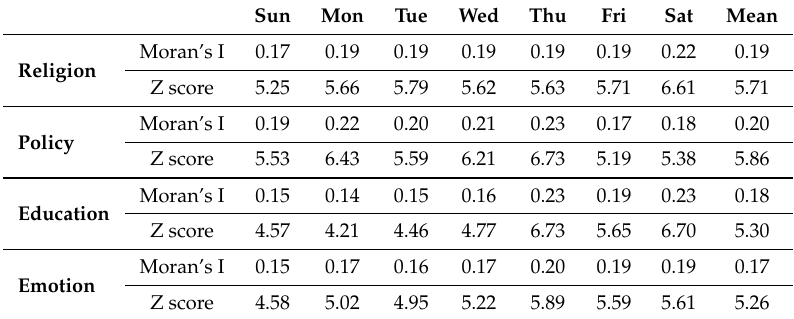
Table 6. Moran’s I for the topics of interest during for each day of the week (All of the statistics are significant at a p -value =